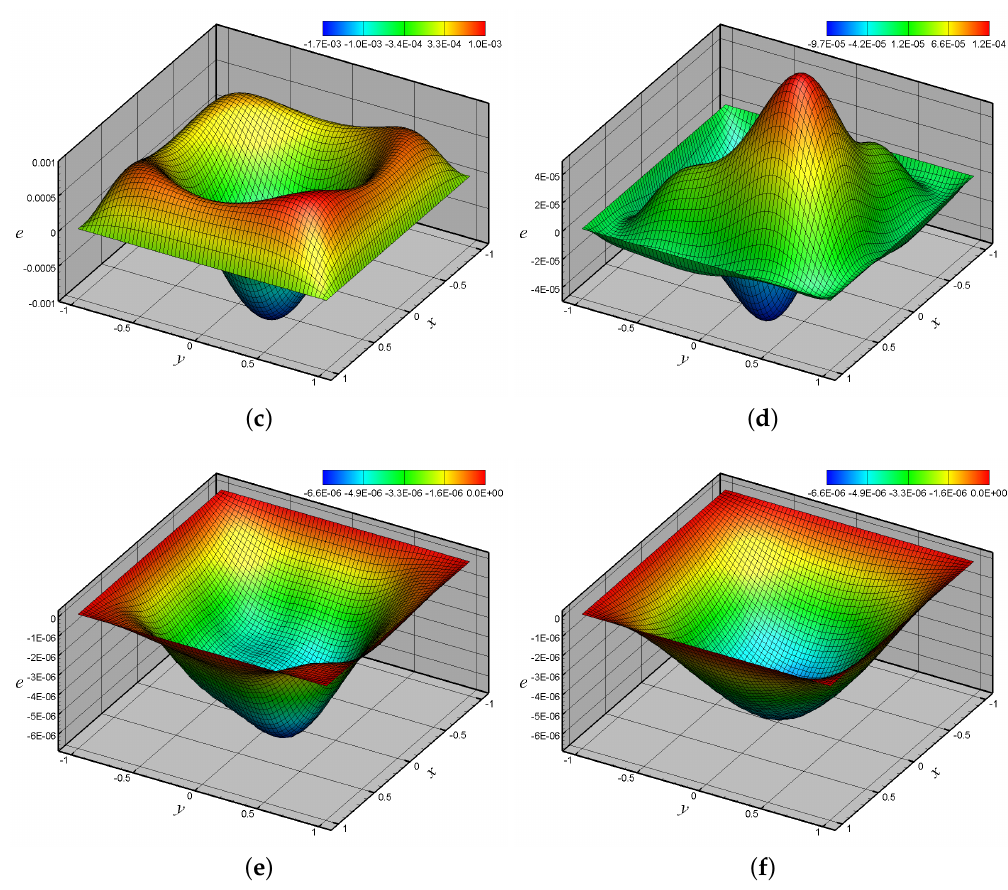
Figure 5. Comparison of the full order model (FOM) and reduced order modeling (ROM) solutions on a resolution of 64 2 grid. ( a ) FOM solution (CPU time: 1.9062 s); ( b ) ROM ( R = 1) solution (CPU − u Exact ); ( d ) error (i.e., e = u ROM − u Exact ); ( e ) error (i.e., time: 0.001565 s); ( c ) error (i.e., e = u ROM R = 2 R = 1 − u Exact ); ( f ) error (i.e., e = u ROM − u Exact e = u ROM R = 4 R = 10